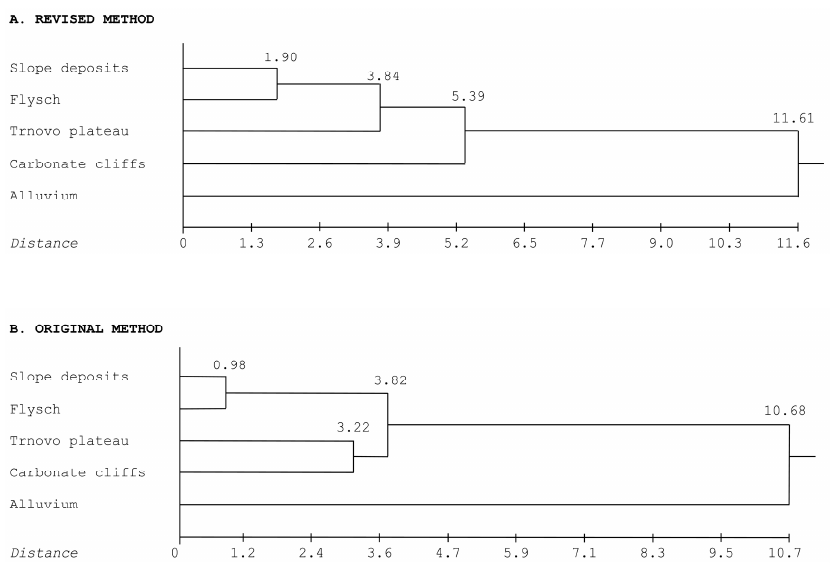
Figure 4. Comparison of the original and revised MLC method results. ( A ) dendrogram of the revised MLC method, and ( B ) dendrogram of the original MLC method.